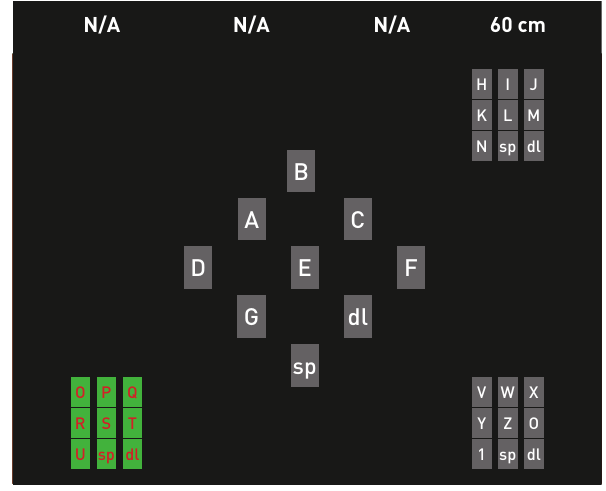
Figure 8. GIBS as discussed in [80]. Figure modified from [80].